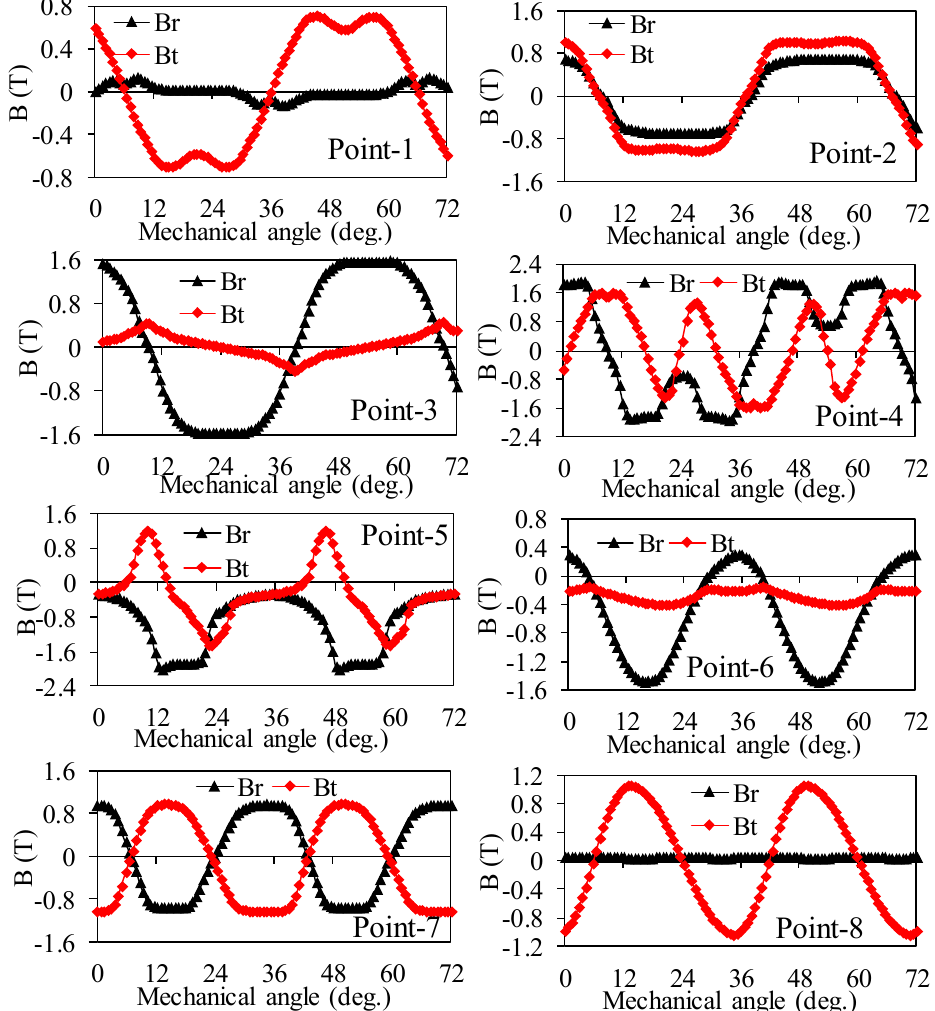
Figure 2. Radial and tangential flux density waveforms of eight key points due to PMs. Figure 3 shows the trajectories of the radial and tangential flux density changes at eight key points when the machine is in no-load operation. There is not only an alternating magnetic field but also a rotating magnetic field in the stator and rotor cores. It can be seen that the change regularity of the flux density at each point on the stator side is completely different from the change regularity of each point on the rotor side. The flux density in the stator yoke and stator teeth changes in a single direction. The flux density in the stator yoke center is mainly a tangential component, while the stator tooth center is mainly a radial component. The stator tooth tip near the air gap has an obvious DC-biased